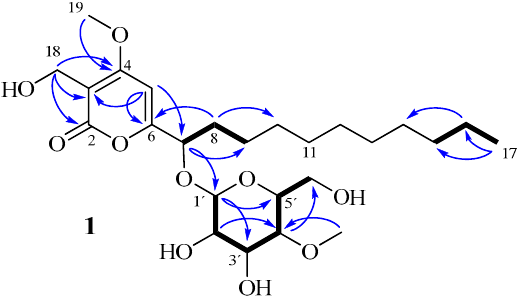
Figure 2. Selected COSY (bold bonds) and HMBC (blue arrows) correlations for akanthopyrone A ( 1 ).